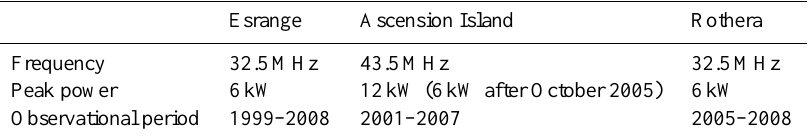
Table 1. Main features of the three meteor radars used in this